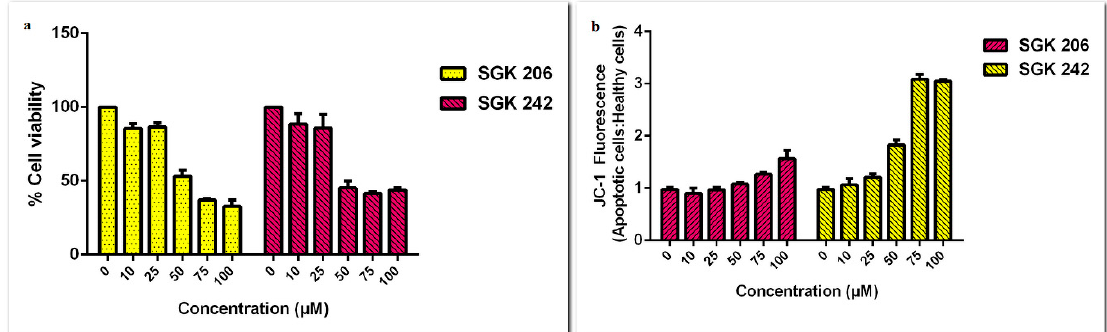
Figure 2 . ( a ) Cell viability assay and ( b ) MMP assay results for different concentrations of SGK 206 and SGK 242 (0–100 μ M) following 24 h incubation in PC-3 cell line.